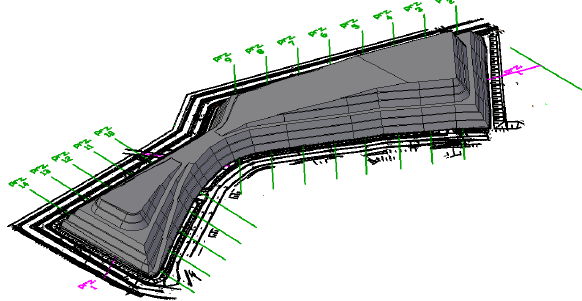
Figure 12: Axonometric view of the location of section lines based on the solid waste landfill (source: the authors’ own edition )